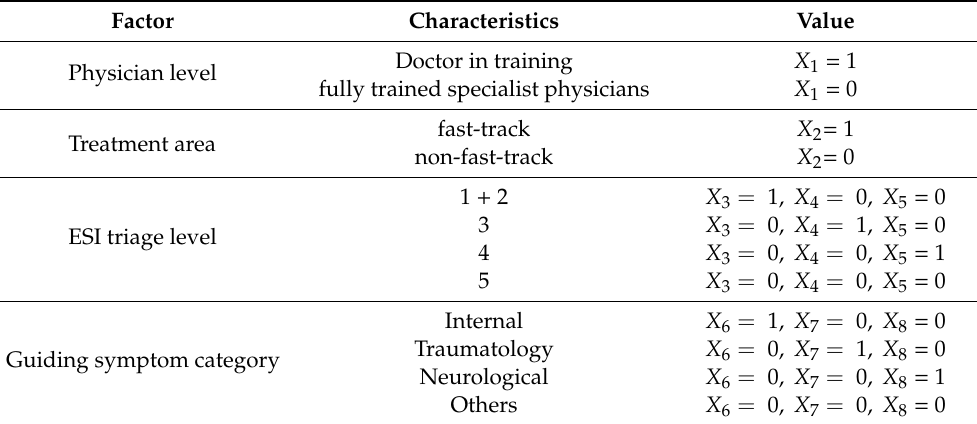
Table 2. Replacing variables for the factors of the prediction